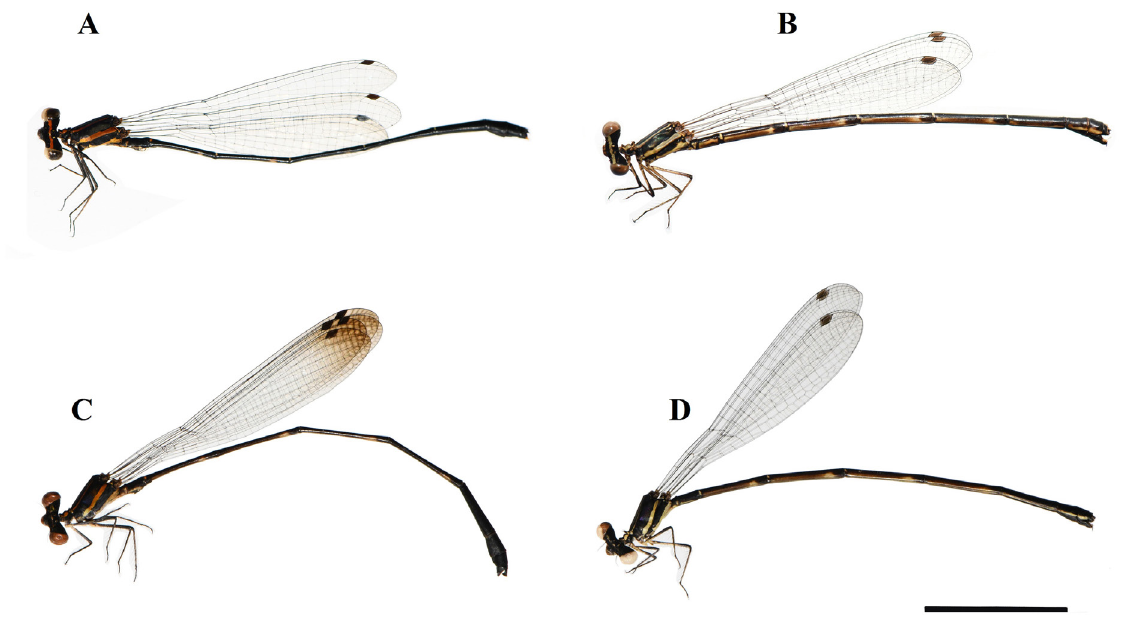
Fig. 14. Habitus of Prodasineura Cowley, 1934 spp. A–B . P. kong sp. nov. A. ♂, holotype, ZCDTU 2019071811-ODO. B. ♀, paratype, ZCDTU 2019071817-ODO. C–D . P. lancastrei sp. nov., C. ♂, holotype, ZCDTU 2019051212-ODO. D. ♀, paratype, ZCDTU 2019051217-ODO. Scale bar = 1